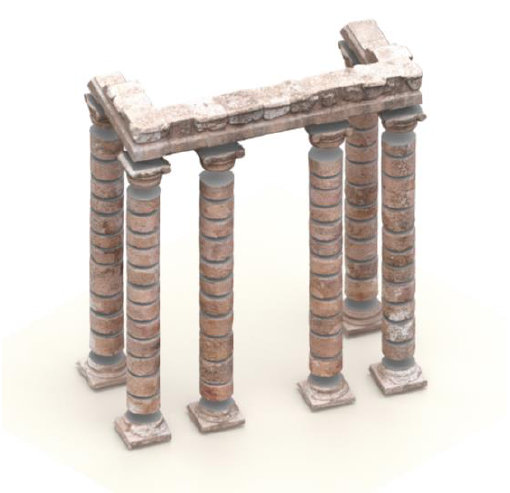
Figure 11. 3D textured mesh model: colonnade segmentation At the end of the process, the root square error [RMSE (cm)] of the check points projection indicates a value in Reference of 2.92074 cm (Table 1).